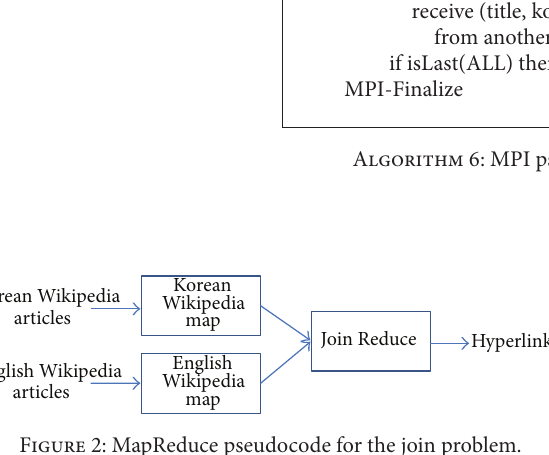
Figure 2: MapReduce pseudocode for the join